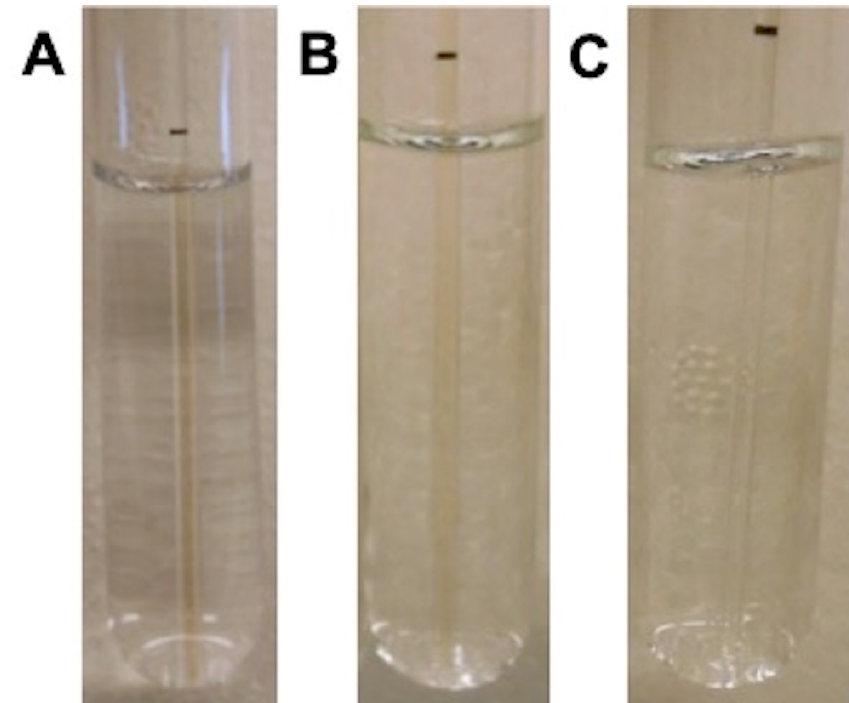
Figure 5. ( A ) Capillary tube kinetically doped with HRP exposed to the guaiacol/hydrogen peroxide assay, showing the dark brown quinone product. This product indicated the enzymes were still active after loading. ( B ) Capillary tube kinetically doped with HRP exposed to the guaiacol/hydrogen peroxide assay after being exposed to methanol for 15 s, still showing the dark brown quinone product. This product indicated the enzymes were still active after methanol exposure. ( C ) Capillary tube post ‐ doped with HRP exposed to the guaiacol/hydrogen peroxide assay after being exposed to methanol for 15 s, with the dark brown quinone product no longer being produced. The lack of this product indicated the enzymes were no longer active.